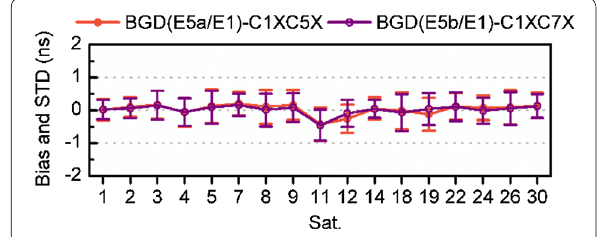
Fig. 1 Statistics of the differences between BGDs and DCBs for Galileo satellites (E1–E30) from 2015–2018. Dots and bars indicate the mean values and the STDs, respectively, of the daily biases